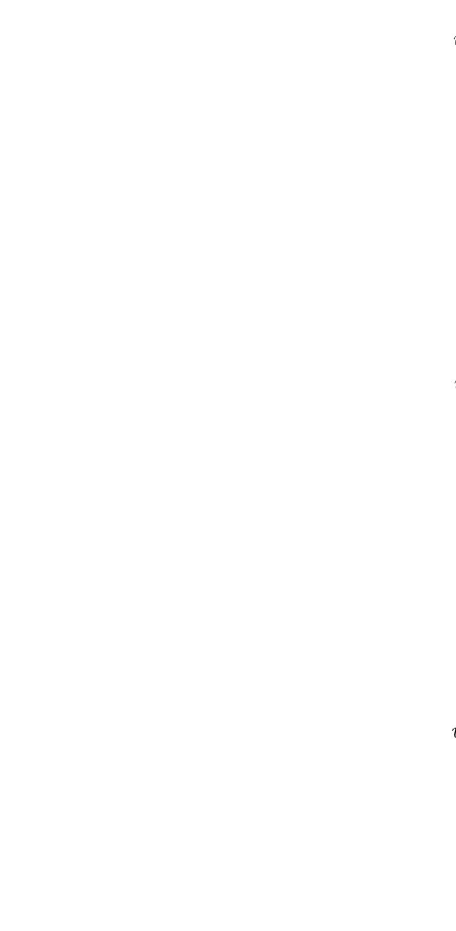
Figure 4 ( a ) The classic CS solution; ( b ) the ROECS solution; ( c ) the error between the ROECS solution and the CS solution when t =